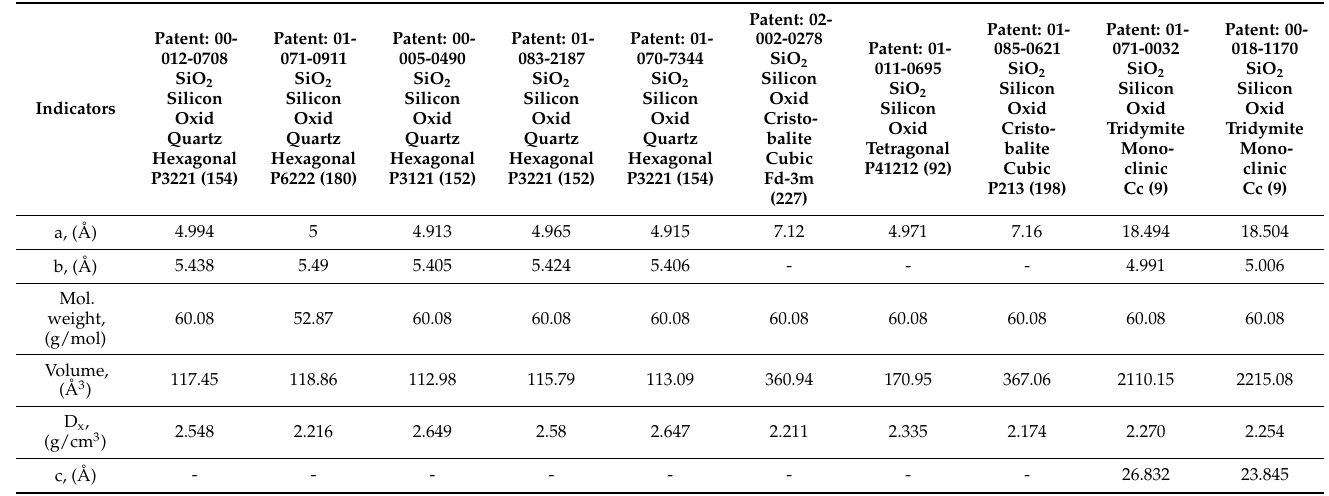
Table 3. The characteristics of the cards used in the research process.